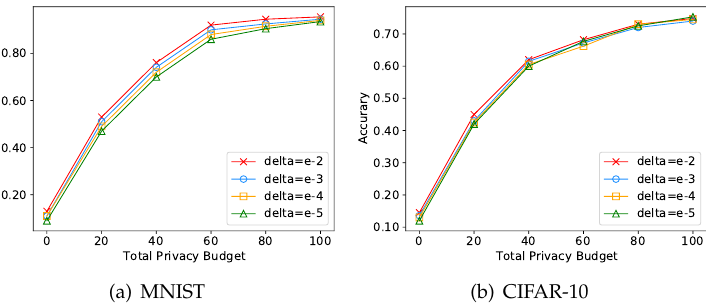
Figure 7. The model accuracy of ADPML under different total privacy budgets for various choices of relaxation factors.